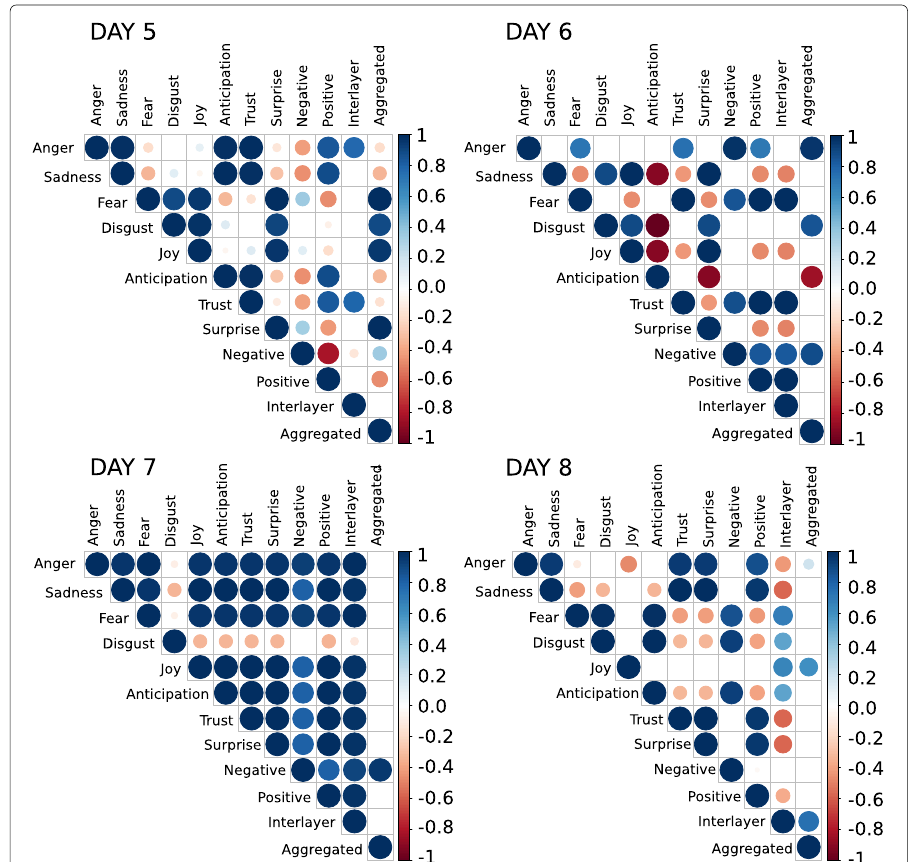
Fig. 12 Pearson correlation coefficient matrix ( p < 0.05) of the daily significance profile (SP) of motif sequences (days 5-8) for each emotion layer of our multiplex network. Only statistically significant values are shown in the